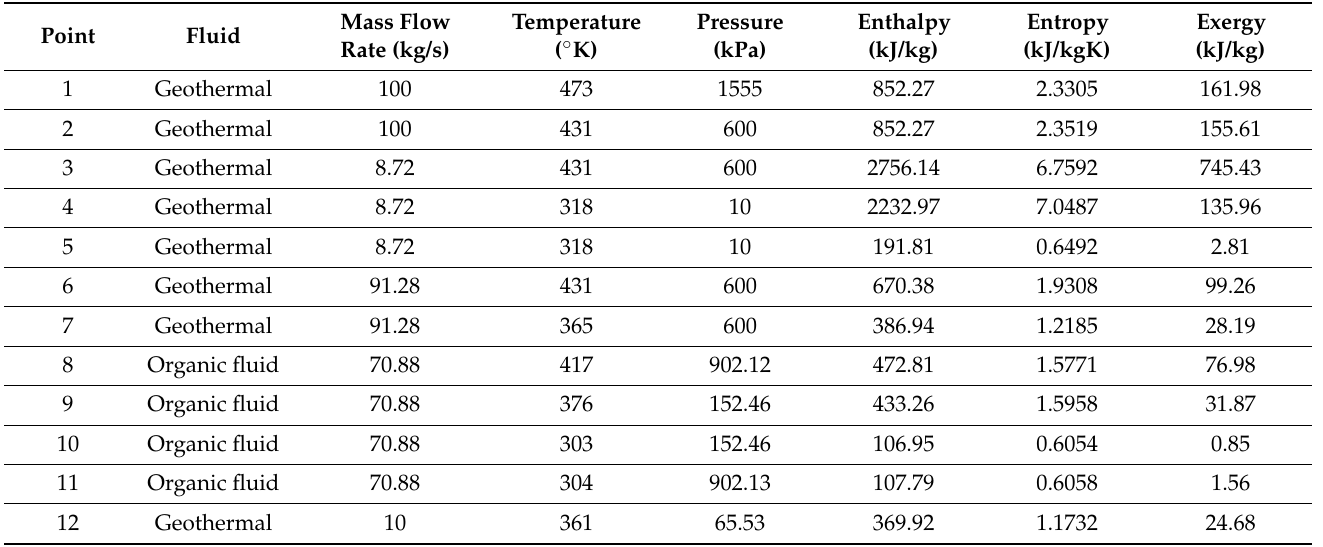
Table 7. Thermodynamic properties, mass flow rate, and exogenous rate of system points for cyclohexane 0.4/R236ea